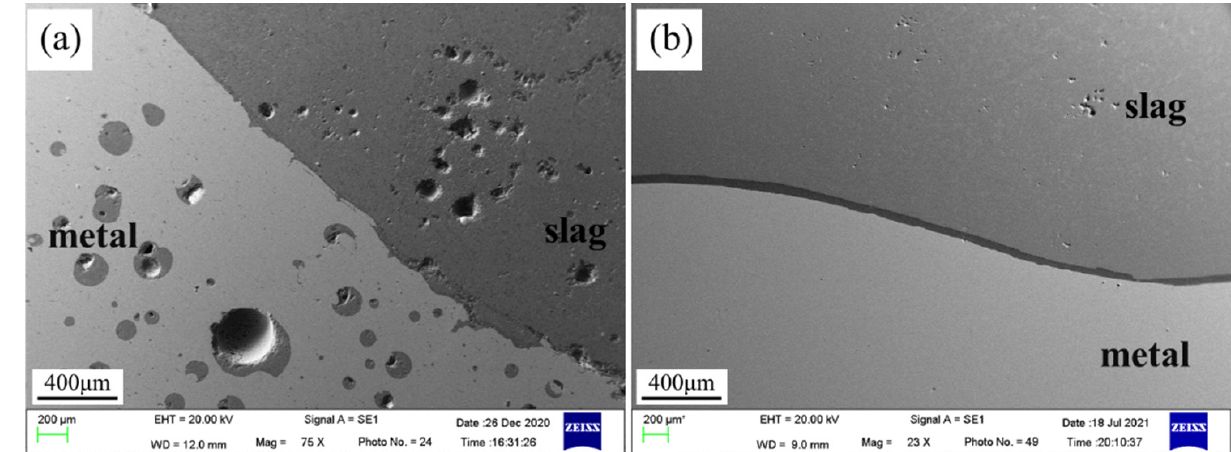
Figure 7. Interfacial morphology of alloy and low SiO 2 slag at 7 min: ( a ) Fe-5Al; ( b ) Fe.